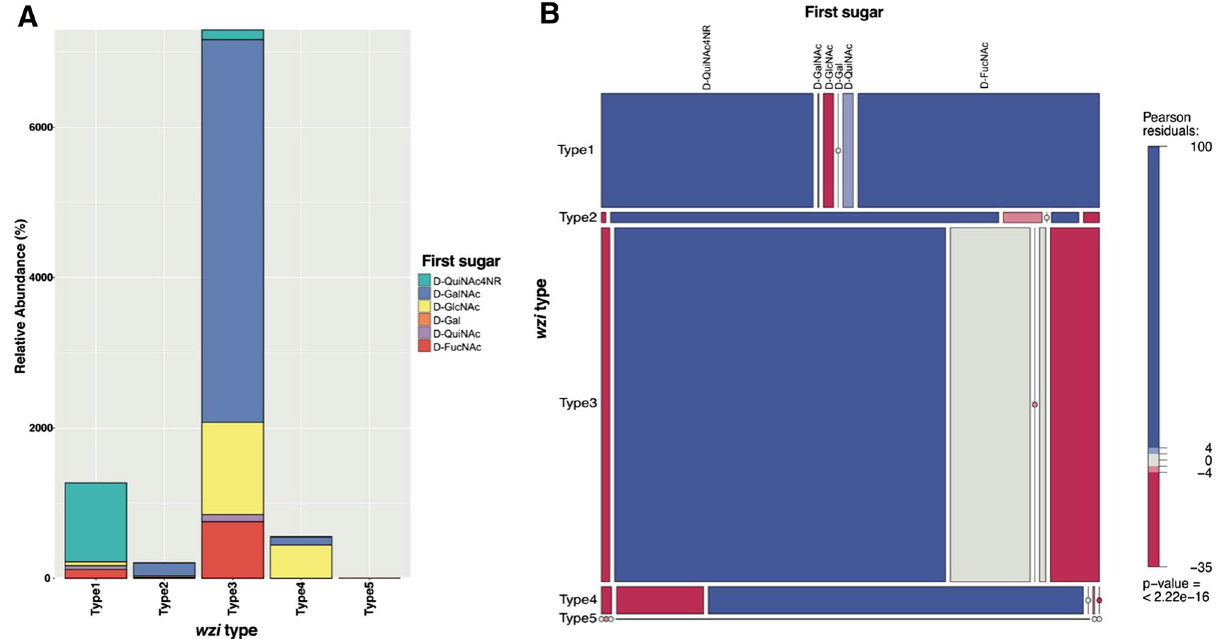
Figure 6. Association between wzi and itr types. ( A ) Stacked bar plot showing the relative abundance of itr types found in A. baumannii genomes grouped by wzi type. Size of the box denotes the relative number of genomes with the indicated itr type (coloured according to scheme shown on the right). ( B ) Mosaic plot demonstrating the association between observed frequencies of wzi and itr types. The width and height of each tile indicates the percentage of genomes with the two categorical variables shown on the x and y axes, respectively. Colours represent standardized residuals of a chi-square test with scale shown on the right. Blue denotes occurrences of wzi and itr combinations that are over-represented, whereas red are under-represented occurrences. Circles are a count of zero.